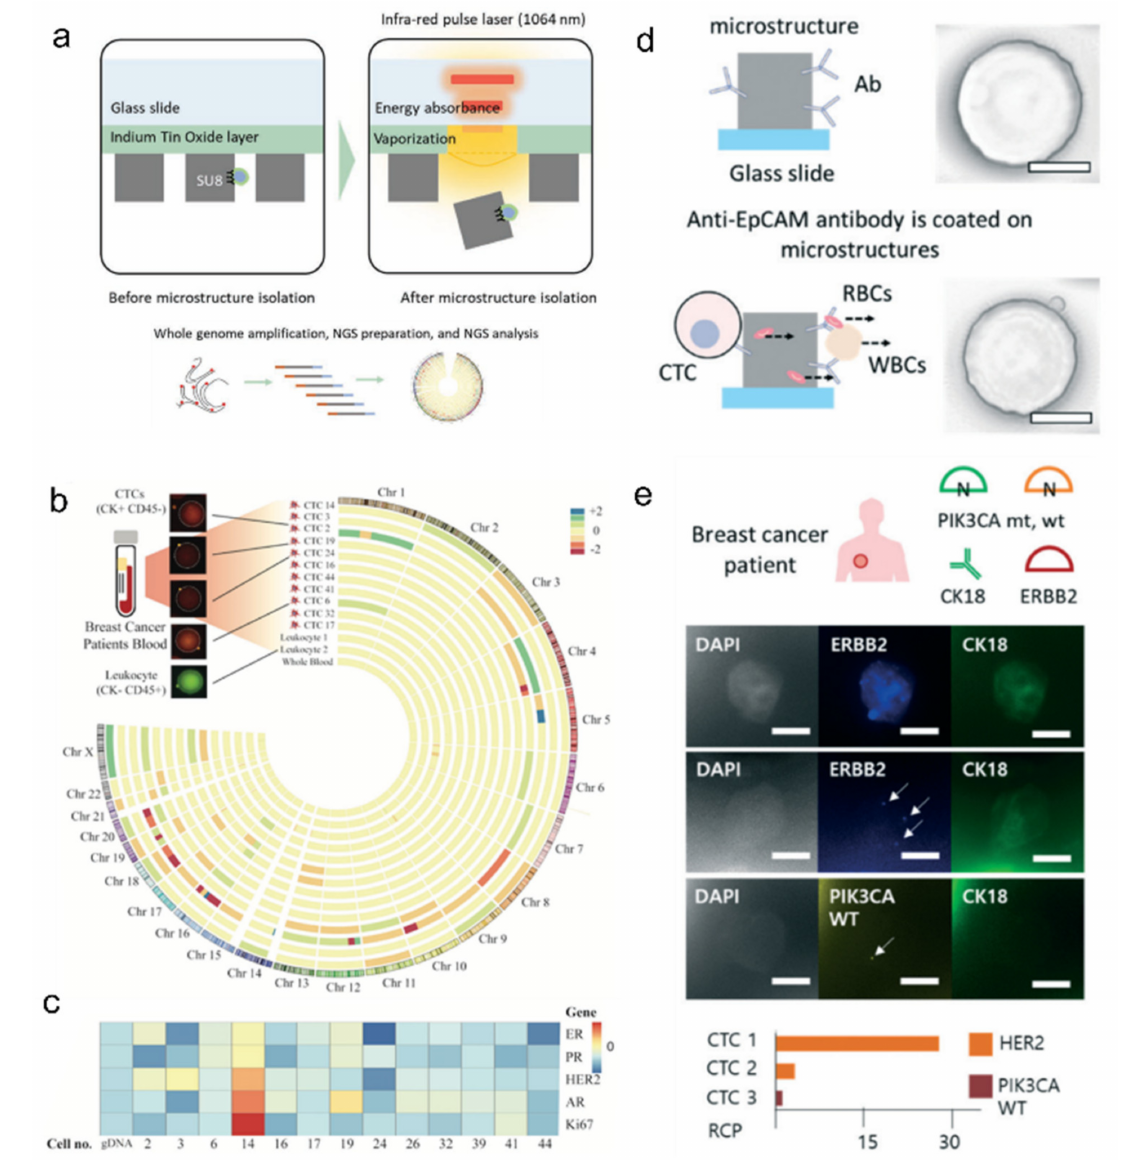
Figure 8. ( a – c ) Whole-genome sequencing of captured CTCs. Pulsed lasers were used for retrieving breast cancer patient-derived CTC. ( a ) Retrieved cells were processed for downstream whole-genome profiling ( b ) and analysis of copy number alteration of tumorigenesis-related gene loci ( c ); adapted with permission from [100]. Copyright 2019 Wiley. ( d , e ) Schematic of antibody-crosslinked polymer post for capturing circulating tumor cells (CTCs) from blood sample; scale bars are 50 µ m. ( e ) In situ molecular profiling of CTCs from breast cancer patient; scale bars are 10 µ m and adapted with permission by the authors of [101]. Copyright 2020